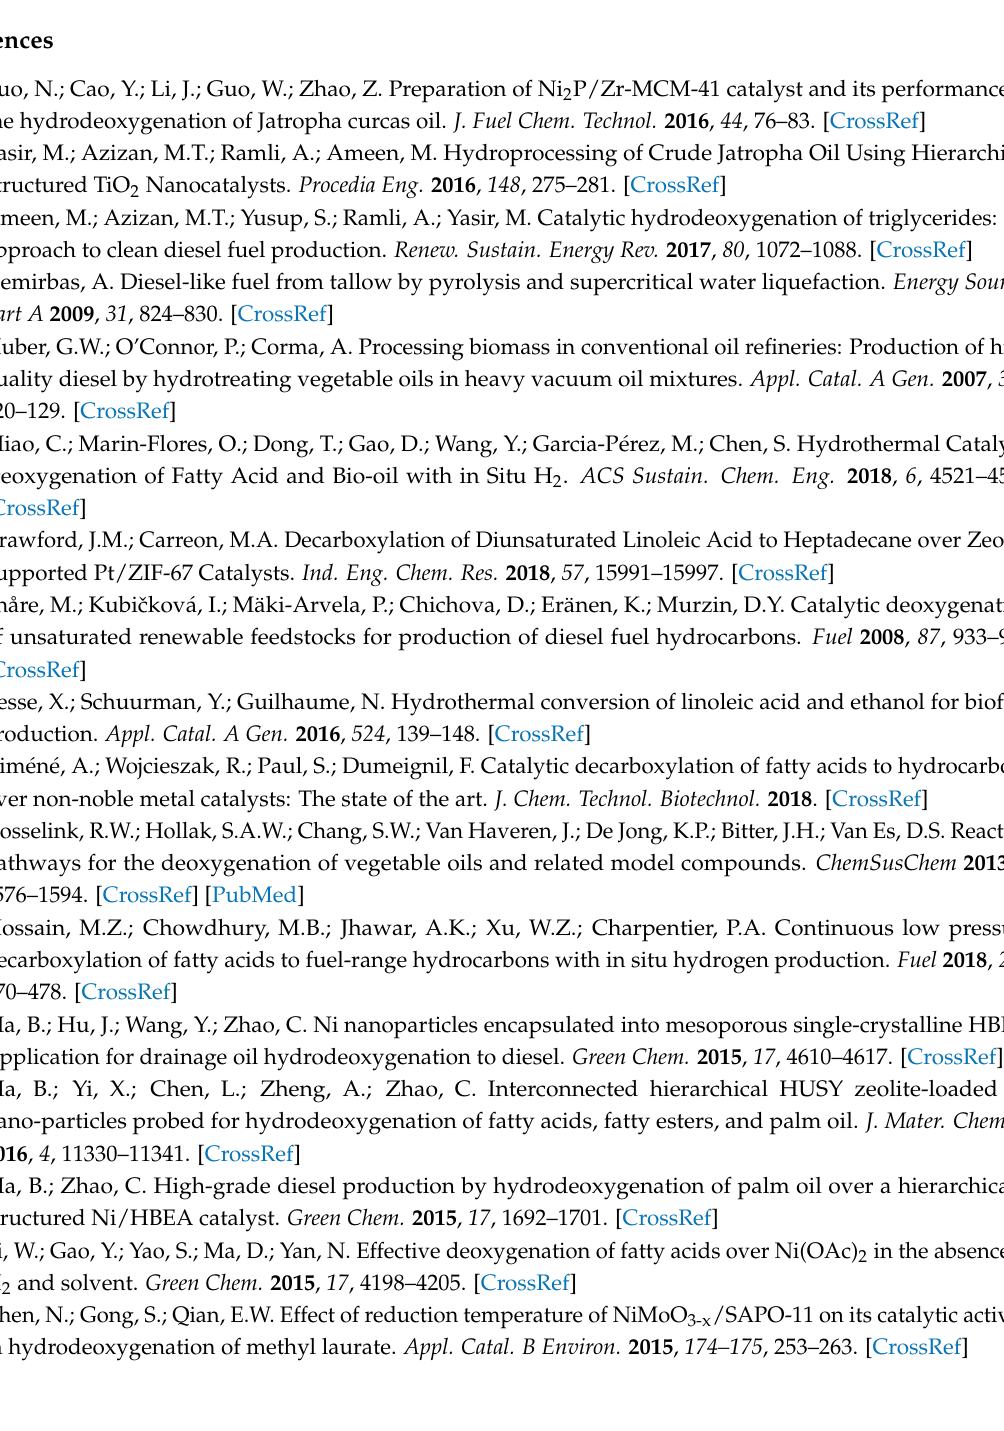
Figure S1: EDX mapping of Fresh Co/NaX, Figure S2: EDX spectrum of parent NaX, fresh Co/NaX, and spend Co/NaX, Table S1: Calculation of the Thiele modulus and effectiveness